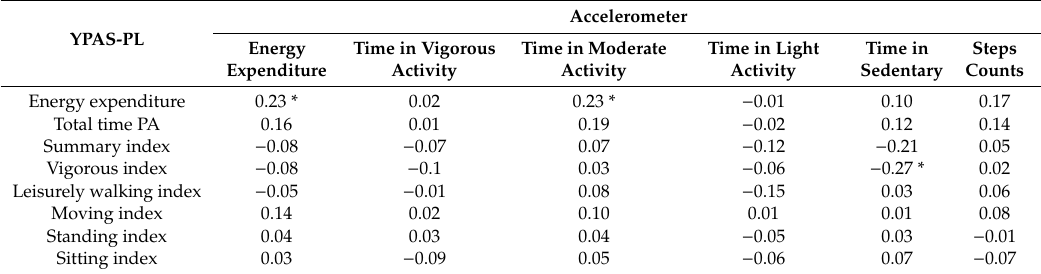
Table 2. Correlation Coe ffi cients between Parameters of Physical Activity Measured by the YPAS-PL and